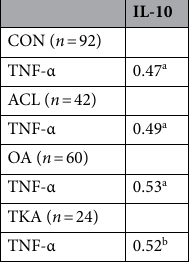
Table 4. Cytokine correlation coefficients in each group. a p < 0.05; b p =